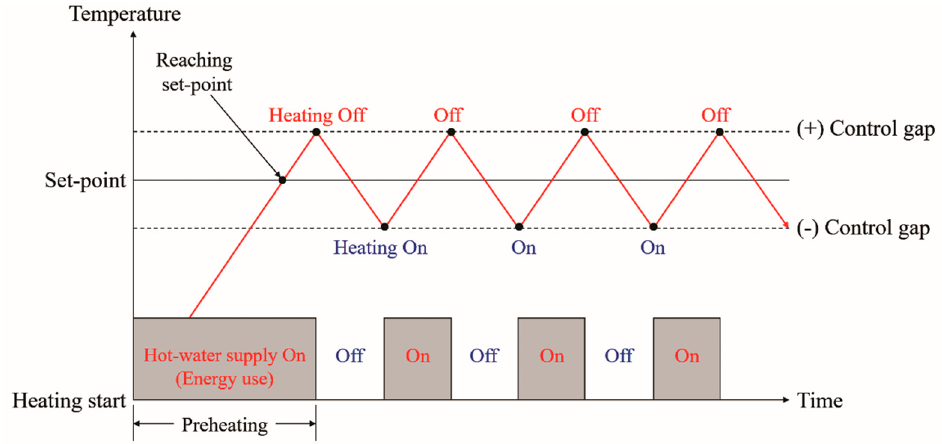
Figure 3. The patterns of the floor surface temperature and the energy consumption in the existing radiant floor heating system.